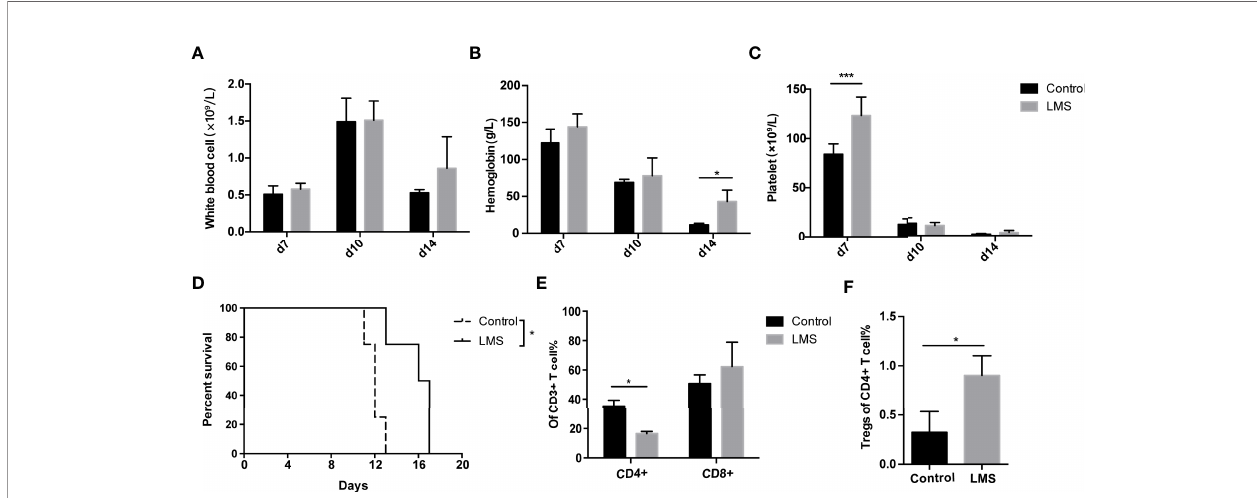
FIGURE 2 | LMS improved pancytopenia and prolonged animal survival in an immune-mediated bone marrow failure murine model. Irradiated CB6F1 recipients were transplanted with C57BL/6 lymph node cells with PBS or 20 mg/kg LMS oral daily administration. (A – C) The white blood cell count, hemoglobin, and platelet levels in the peripheral blood from control and LMS-treated groups were measured at days 7, 10, and 14 (Control group: n = 4; LMS-treated group: n = 4). (D) Overall survival was shown in each group (Control group: n = 5; LMS-treated group: n = 5). (E) The percentage of CD4 + and CD8 + T cells in CD3 + T cells in the spleens of two groups on day 14 ( n = 3). (F) The percentages of CD4 + Foxp3 + Tregs in the spleens of two groups on day 14 ( n = 3). * p < 0.05; ** p < 0.01; *** p <